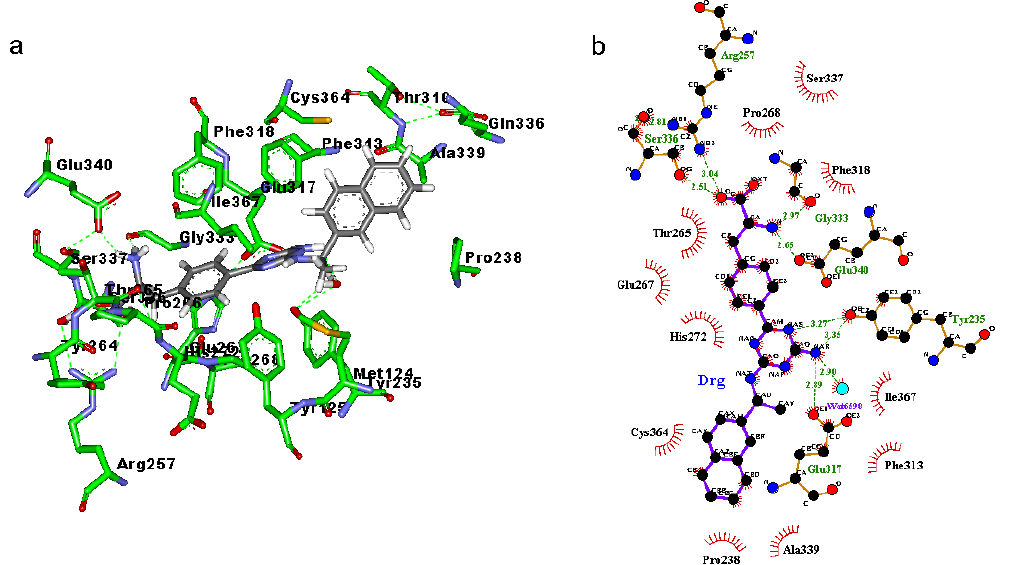
Figure 6. ( a ) Binding modes of inhibitor 1c with the key residues of TPH1 that are essential for the binding; ( b ) 2D contour of the binding modes generated by Ligplot